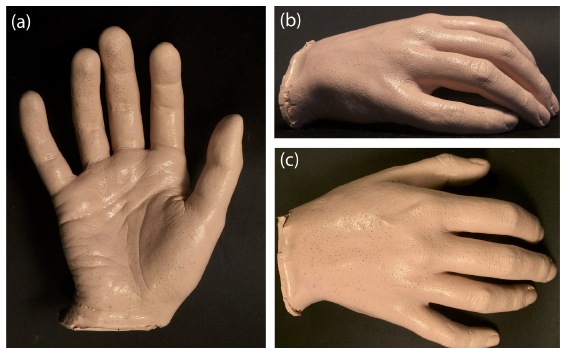
Figure 1. Three-dimensional copy of a human palm (female) with 1:1 scale reproduction, as seen from different angles ( a – c